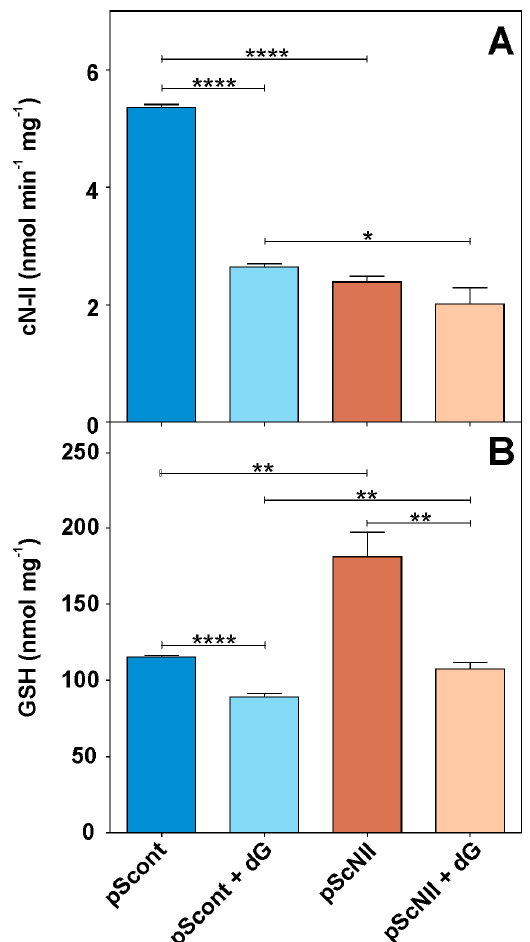
Figure 1. Effect of cN-II silencing on GSH content in A549 cells. ( A ) cN-II activity in pScont and pScNII grown 24 h in the presence or absence of 20 mM dG; ( B ) cellular content of reduced glutathione in the same samples. Results are the mean + SEM of three independent experiments. * p < 0.05, ** p < 0.01, **** p < 0.0001.